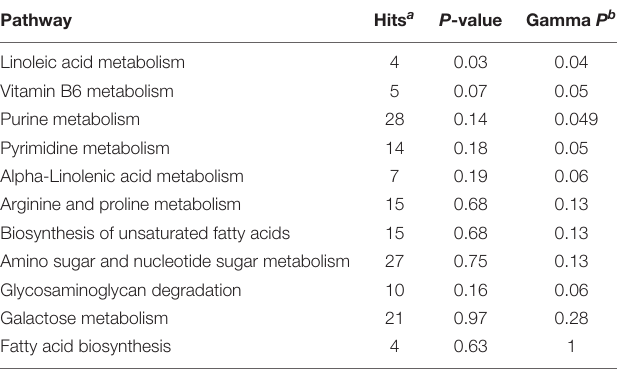
TABLE 4 | Analysis of enriched metabolic pathways in buffalo and cow milk for negative ion